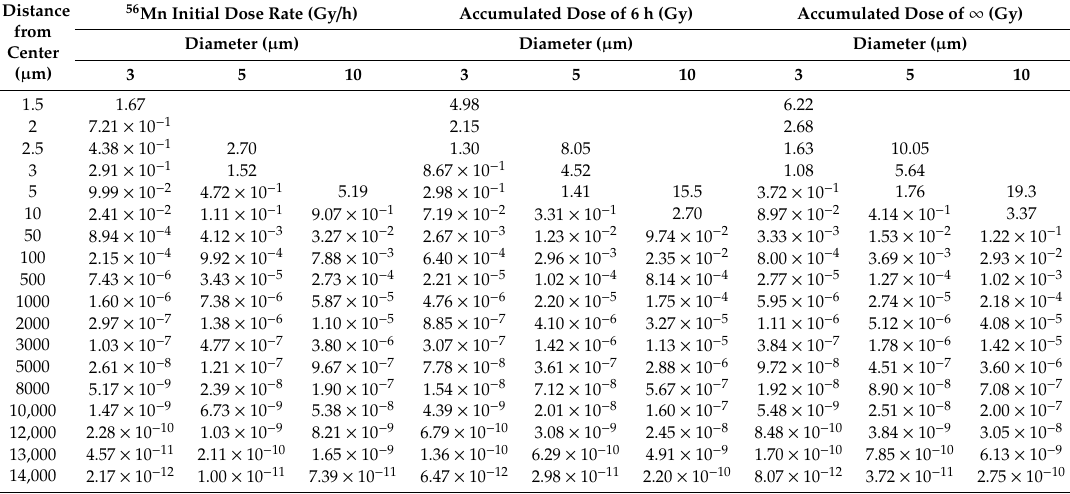
Table 3. Absorbed dose rate and the accumulated dose surrounding the 56 Mn